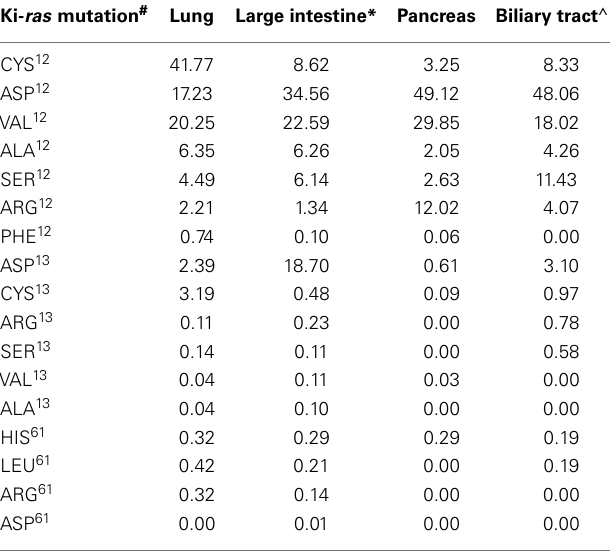
Table 1 | Relative frequencies of the major Ki- ras mutations by cancer type: analysis of the Sanger COSMIC